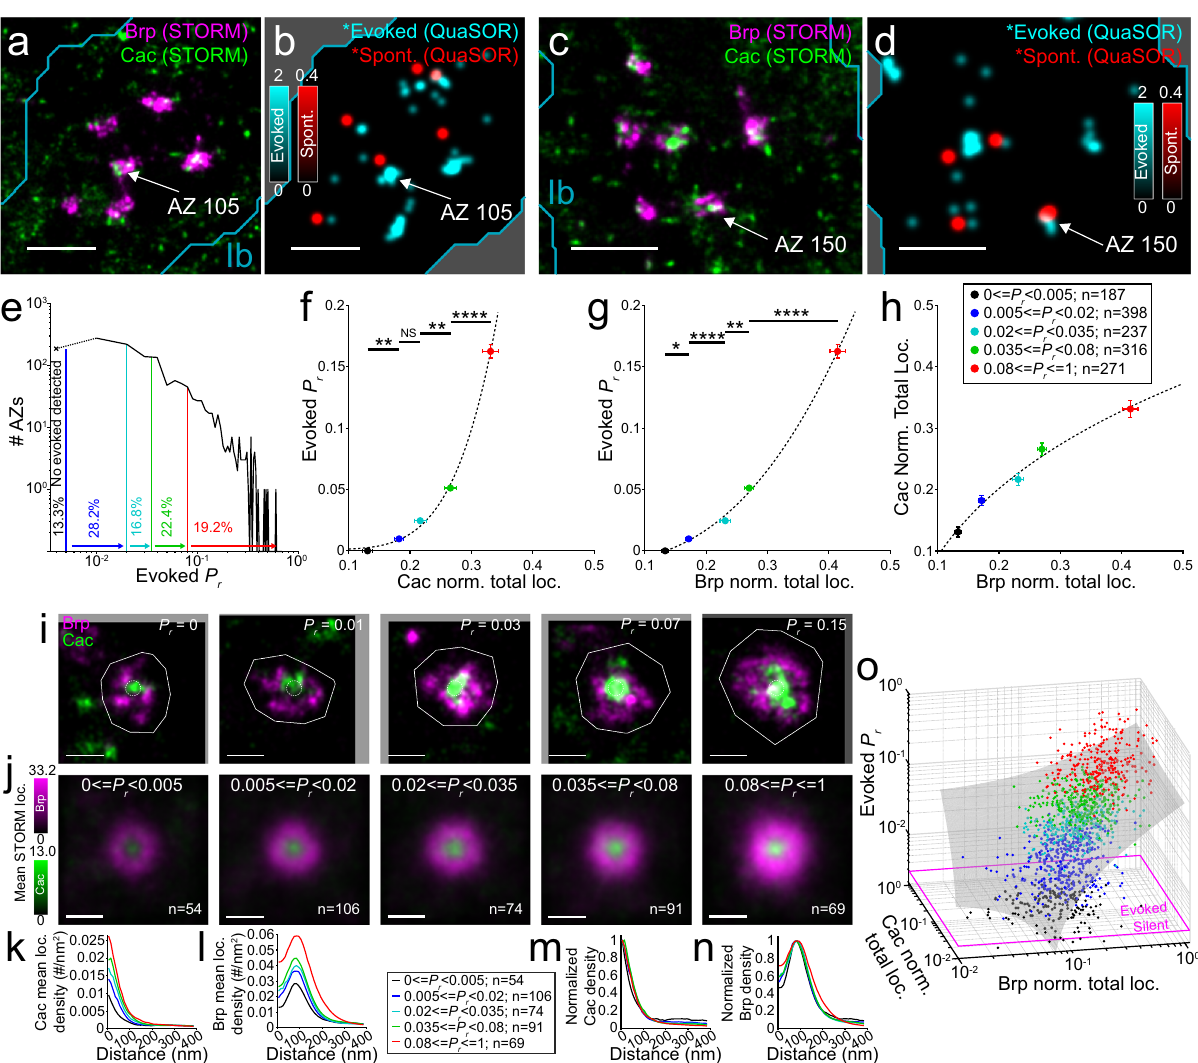
Fig. 3 QuaSOR-STORM: Cac and Brp promote P r but account for only a fraction of P r variance. a – d QuaSOR-STORM alignment examples. WT Ib boutons showing Brp and Cac 3D-STORM z -projections ( a , c ) alongside STORM-aligned QuaSOR map ( σ = 42.3 nm) for evoked (*; cyan) and spontaneous transmission (*; red) ( b , d ). e WT Ib AZ evoked P r distribution with bin edges (see f – h ) and percentages ( n = 1409 QuaSOR-STORM matched Ib AZs, 9 NMJs; 200 stimuli at 0.2 Hz episodic protocol). (×) indicates fraction of sites with no detected evoked transmission. f , g P r dependence on Cac ( f ) and Brp ( g ). P r -binned, mean NMJ-normalized total STORM localizations per AZ versus mean evoked P r for all AZ orientations. ( f , R 2 = 0.998; y = 42 x 5.0 + 0.001; One-way ANOVA p = 5.8 × 10 − 41 ; Tukey-Kramer post hoc test; bin 1 vs bin 2 p = 0.0056; bin 2 vs bin 3 p = 0.097; bin 3 vs bin 4 p = 0.0063; bin 4 vs bin 5 p = 3.0 × 10 − 5 ; g , R 2 = 0.998; y = 1.7 x 2.6 − 0.01; One-way ANOVA p = 1.2 × 10 − 119 ; Tukey – Kramer post hoc test; bin 1 vs. bin 2 p = 0.012; bin 2 vs bin 3 p = 7.3 × 10 − 9 ; bin 3 vs bin 4 p = 0.0071; bin 4 vs bin 5 p = 9.9 × 10 − 9 ; mean ± SEM). h Non-linear Brp-Cac relationship. P mean NMJ-normalized total STORM localizations per AZ for Brp versus Cac ( R 2 = 0.987; y = 1.2 x 0.2 − 0.65). i Representative en face AZs (from same NMJ) showing 3D-STORM overlay z -projections for Brp (magenta) and Cac (green) for each P r -binned group in e . AZ borders (solid white lines). Core 40 nm radial region (white dotted circles). j Average Brp and Cac densities across P r . Aligned, spatially averaged en face projections for Brp (magenta) and Cac (green) from bins in e (9 NMJs). k , l Radial mean STORM localization density pro fi les for en face AZs showing Cac ( k ) and Brp ( l ). m , n Relative Cac ( m ) and Brp ( n ) radial pro fi le dimensions across P r showing bin-normalized mean radial density pro fi les for corresponding en face AZ pro fi les ( k , l ). o Pooled NMJ-normalized total Brp versus Cac total STORM localizations P r for all AZ orientations. P r detection threshold (magenta line). 3D fi t (gray plane) is linear polynomial surface ( R 2 = 0.312 P r = − 0.014 + 0.21 Brp + 0.053 Cac ; n = 1409 AZs, 9 NMJs). Scale bars: 1 µ m ( a – d ); 200 nm ( i , j